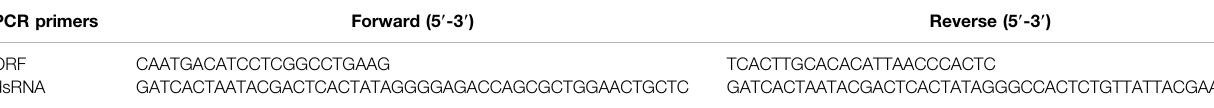
TABLE 2 | PCR primers for Wnt10b RNA interference.